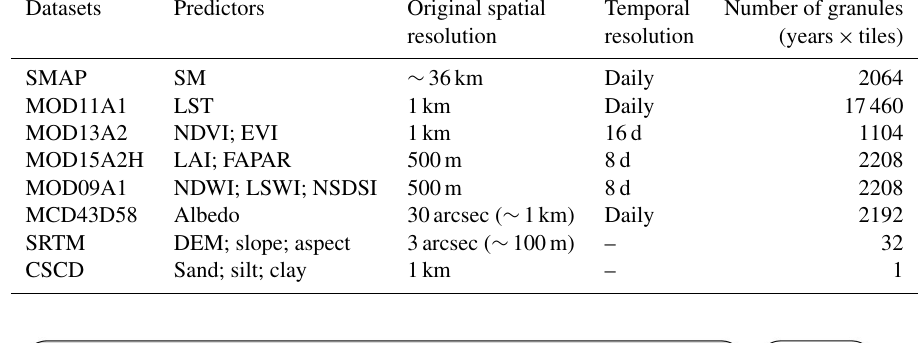
Table 2. Main predictors used in the study and corresponding datasets.